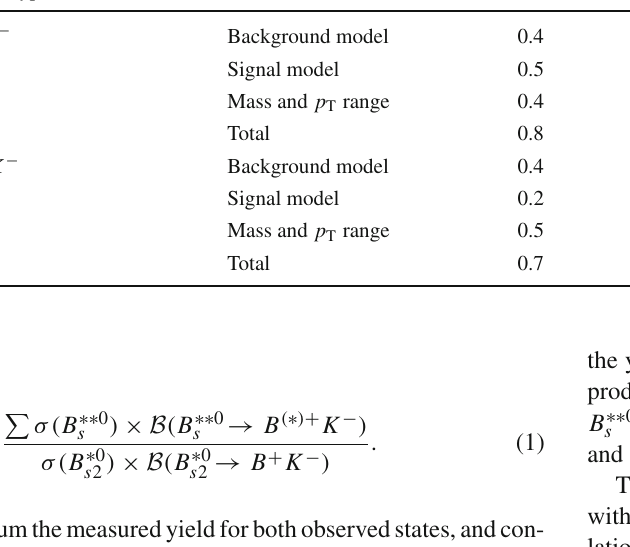
Table 1 Sources of systematic uncertainty on the peak parameters assuming a two-peak structure decaying either directly to B + K − or through B ∗+ K − . The parameter differences with respect to the nominal fit result are given in MeV Decay